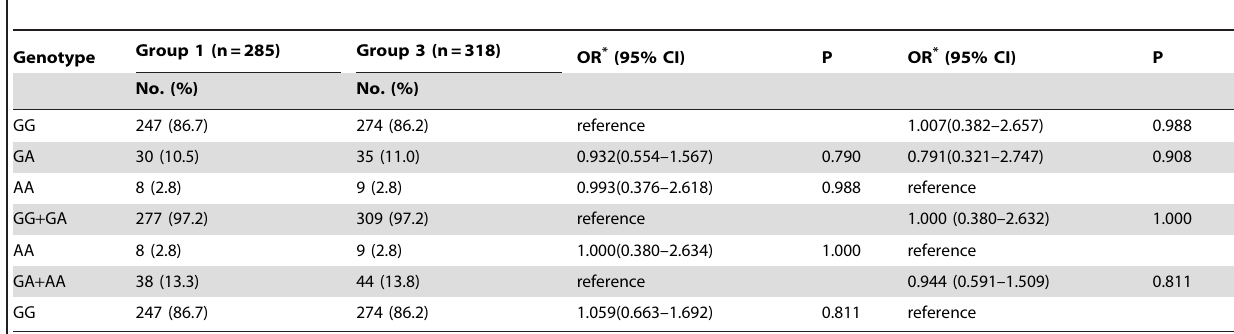
Table 4. ORs comparison between Group 1 (cervical cancer) and Group 3 (HPV negative with no cervical cancer).